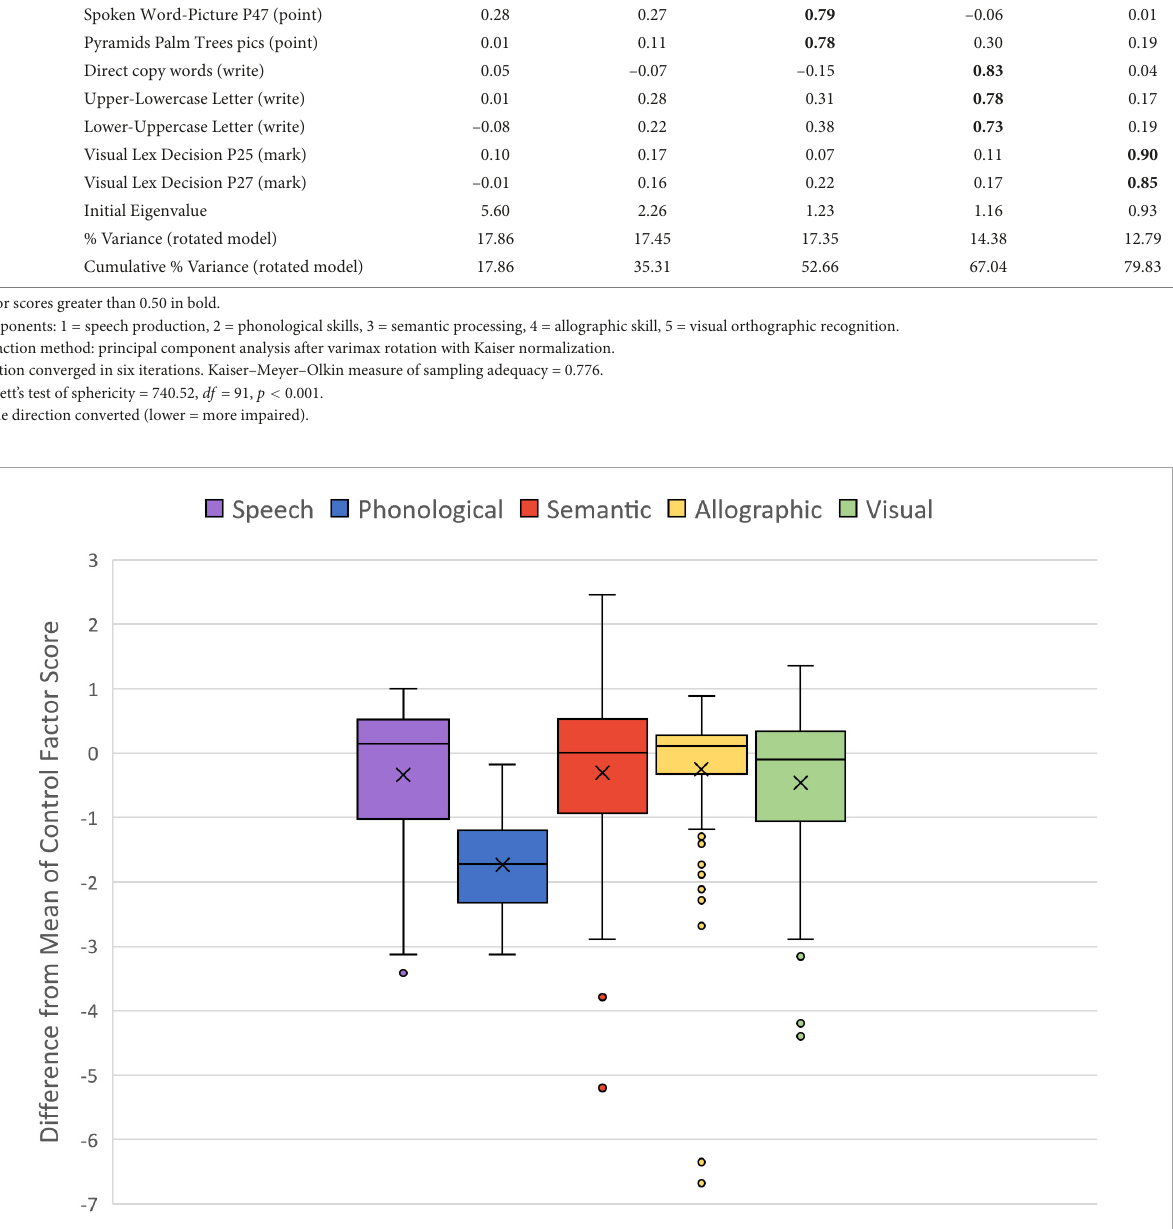
FIGURE3 Box plots showing the distribution of factor scores as they differed from control means. Box boundaries are first and third quartiles, x =